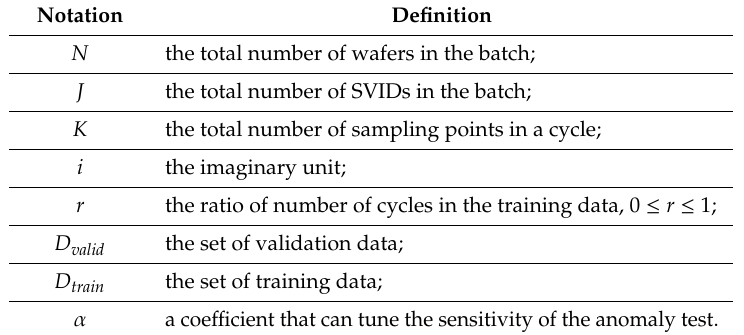
Table 1. Notations of constants or given sets.